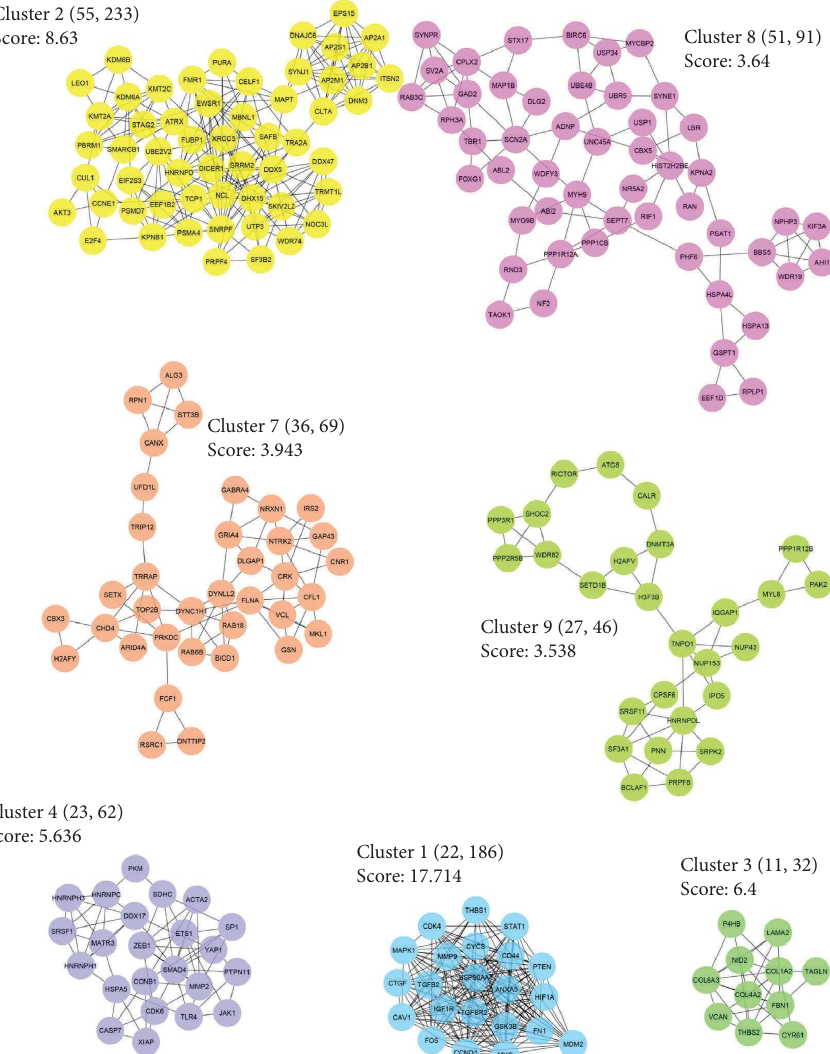
Figure 2: Seven clusters were identifed by the MCODE plugin within the PIM associated with the pathogenesis of OTSCC and BSCC. Te network was built based on validated targets of common DEMs in two subtypes of OSCC. MCODE, molecular complex detection; PIM, protein interaction map; OTSCC, oral tongue squamous cell carcinoma; BSCC, buccal squamous cell carcinoma; DEM, diferentially expressed